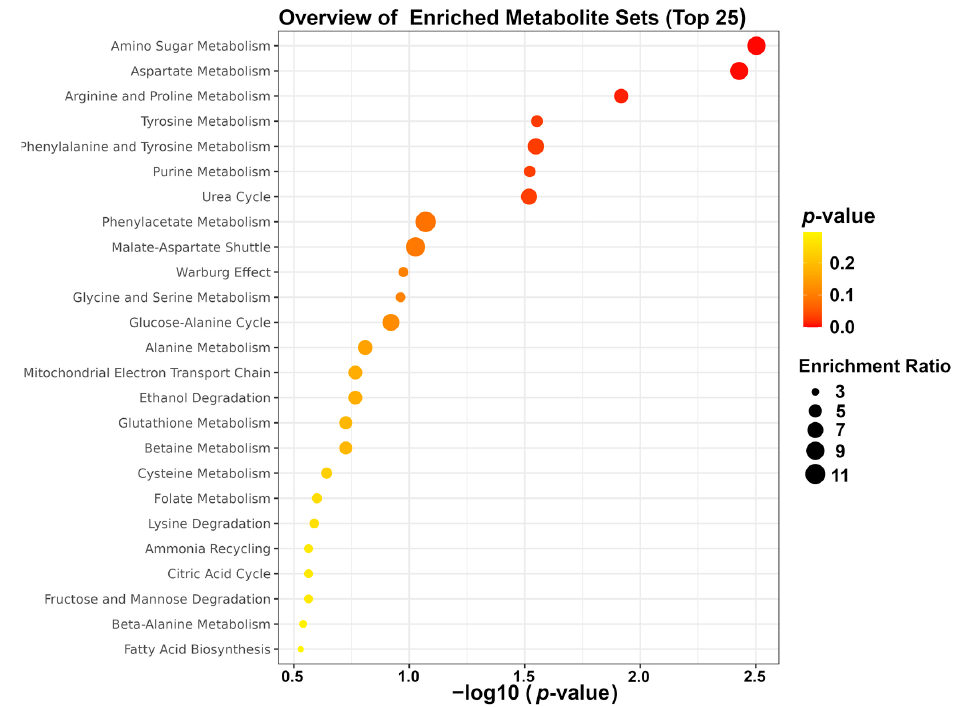
Figure 7. Enrichment analysis.